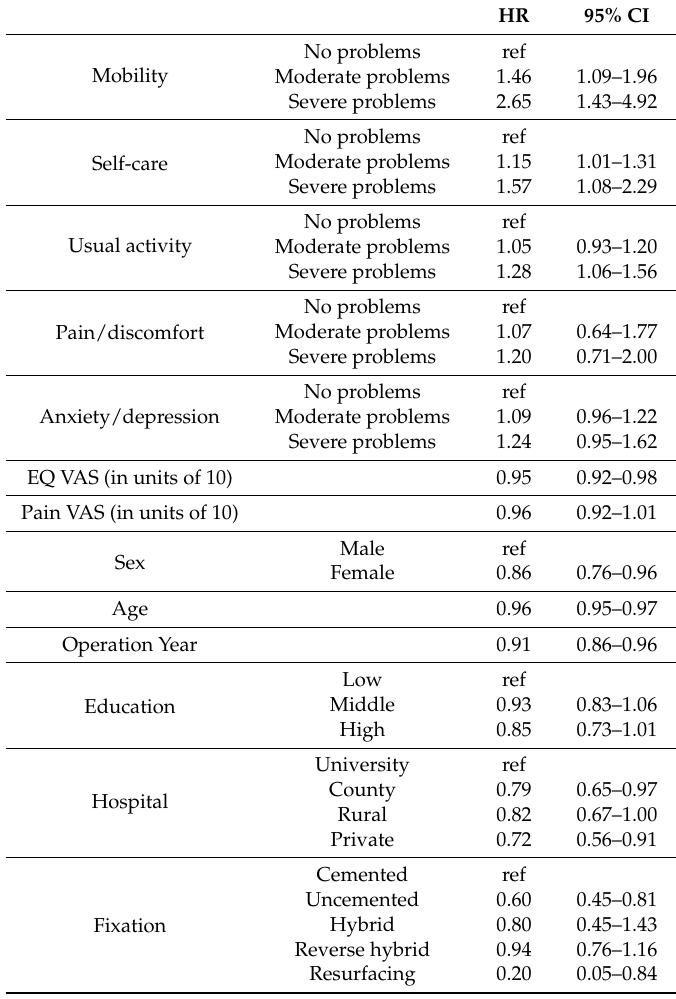
Table 2. Results of the relative survival regression analysis on mortality after total hip replacement. The results are presented as Hazard Rates (HR) and associated 95% confidence intervals